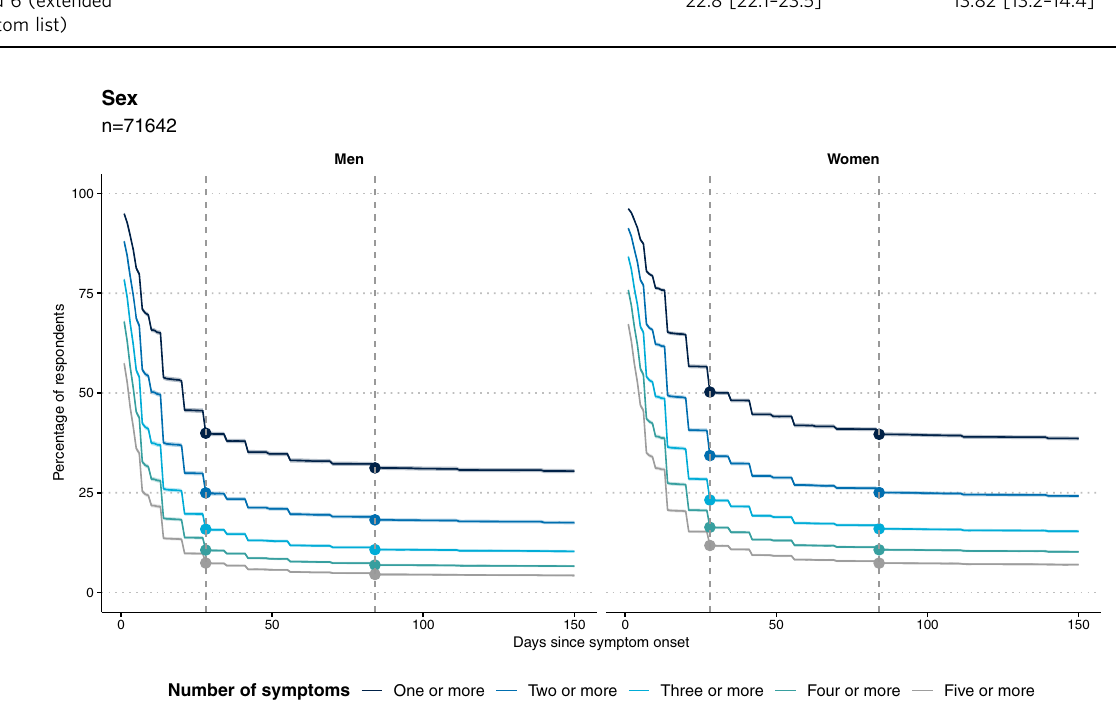
Fig. 2 Persistence of symptoms over time. Plots showing persistence of symptoms as a proportion of those who reported symptoms at any time, among n = 71,642 respondents for whom we had 150 days ’ observation time. Women have higher rates of persistent symptoms; a slower decline in symptom prevalence is observed after 12 weeks in both sexes. The vertical dashed lines show 4 and 12 weeks post symptom onset,